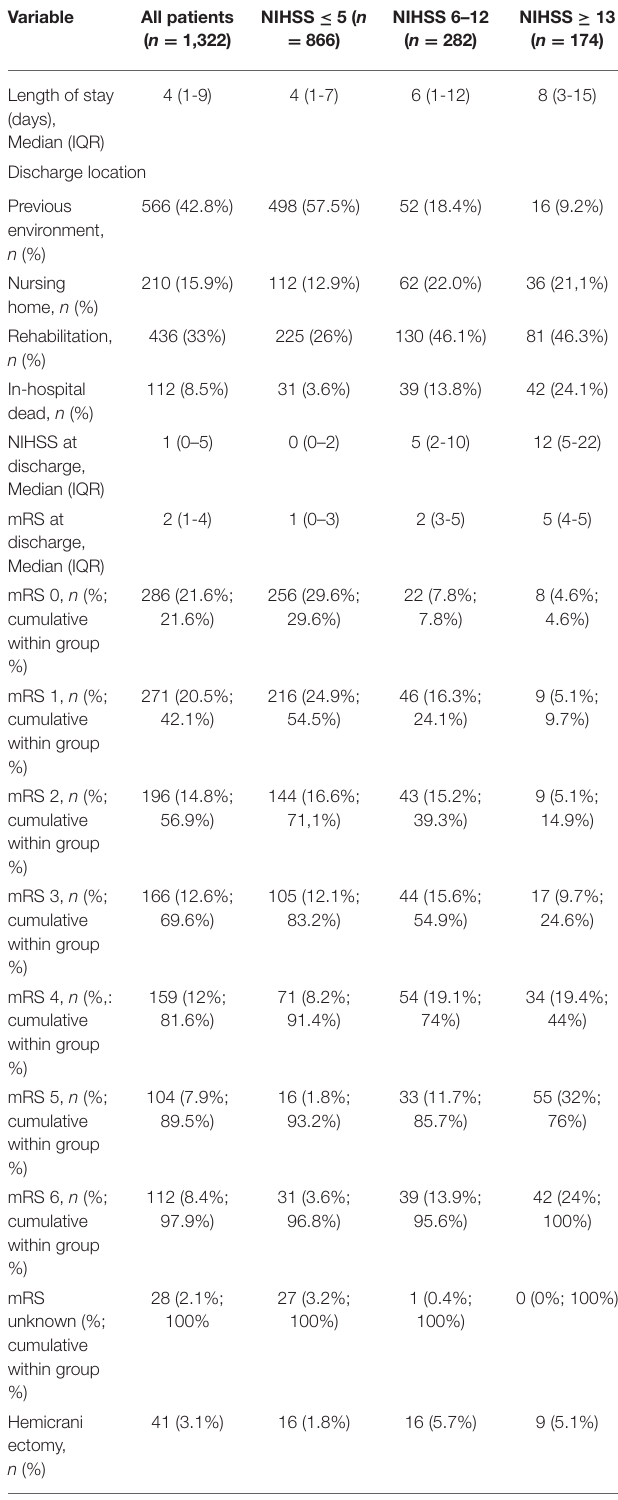
TABLE 2 | Overview of outcome variables stratified by